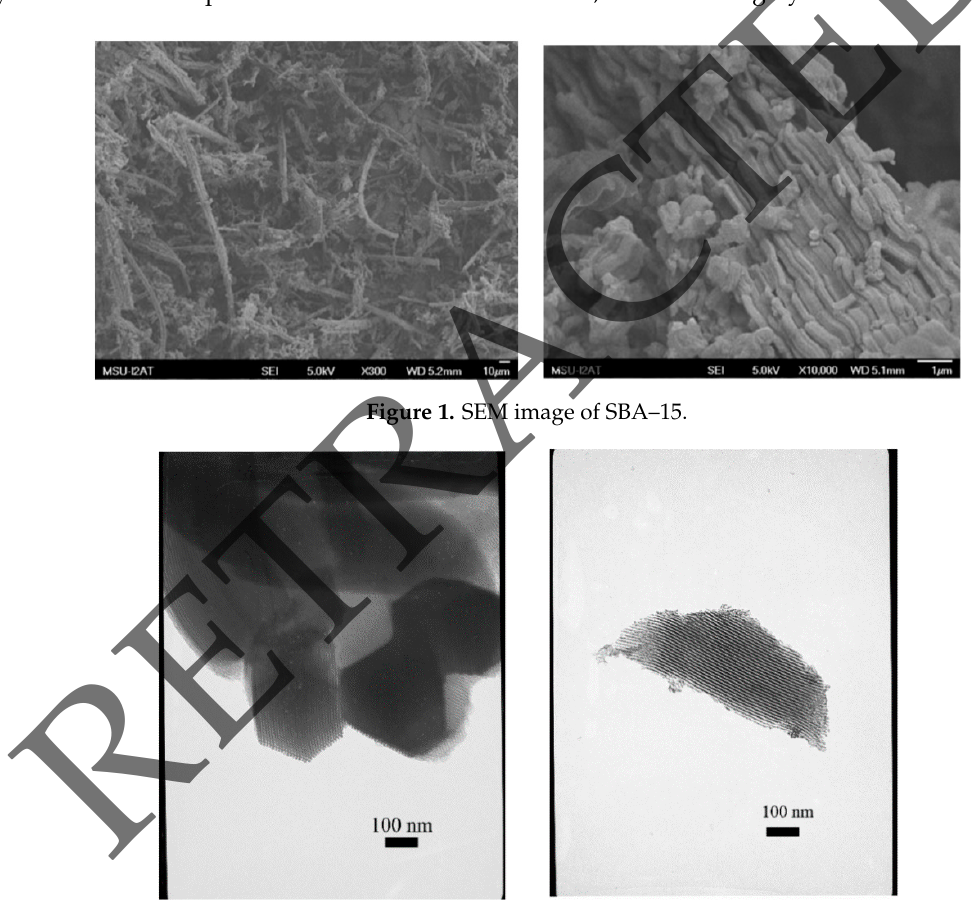
Figure 2. TEM image of SBA–15.